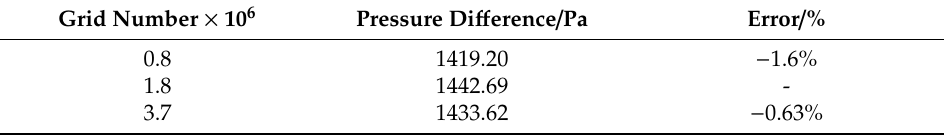
Figure 3. Pressure distribution along the same streamline under di ff erent grid numbers. Table 1. The pressure di ff erence between the inlet and the outlet under di ff erent grid